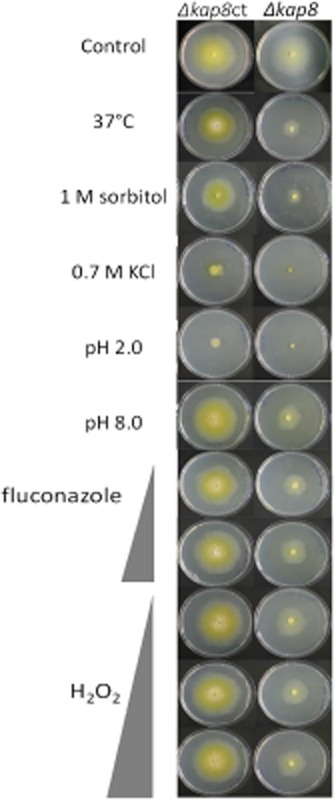
Growth of T. reesei Δkap8 and the complemented transformant (Δkap8ct) on PDA in the presence of various stress-inducing agents: from top to bottom 1.5, 10 and 20 mM H2O2; from top to bottom 0.5 and 2 μg ml−1 fluconazole. Other concentrations/conditions are directly indicated. The plates shown are from a single experiments, but two further biological replicates yielded consistent results.